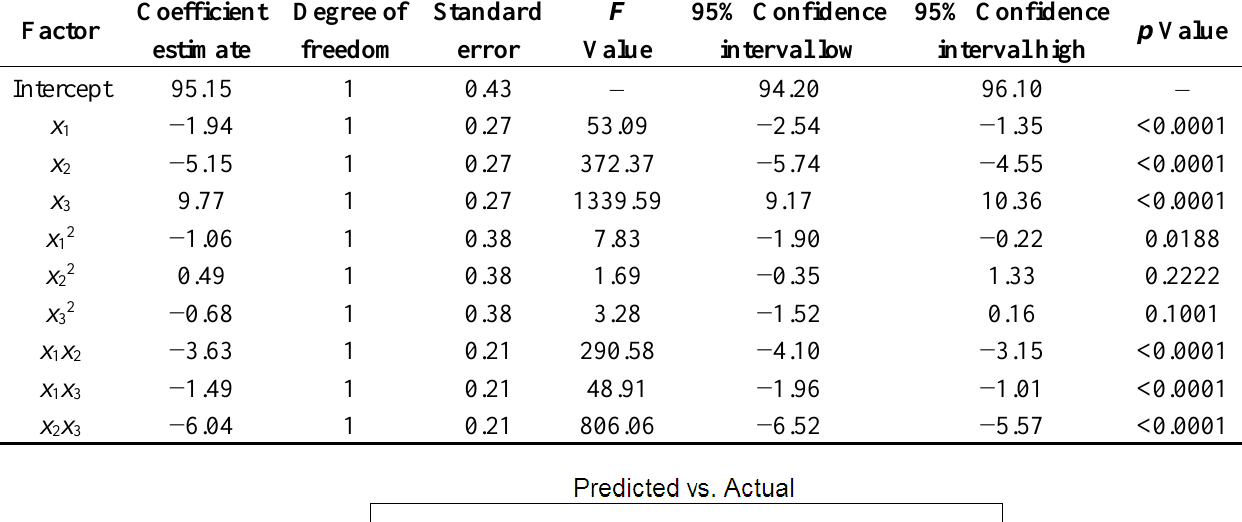
Table 5. Coefficient of regression model and their significance.